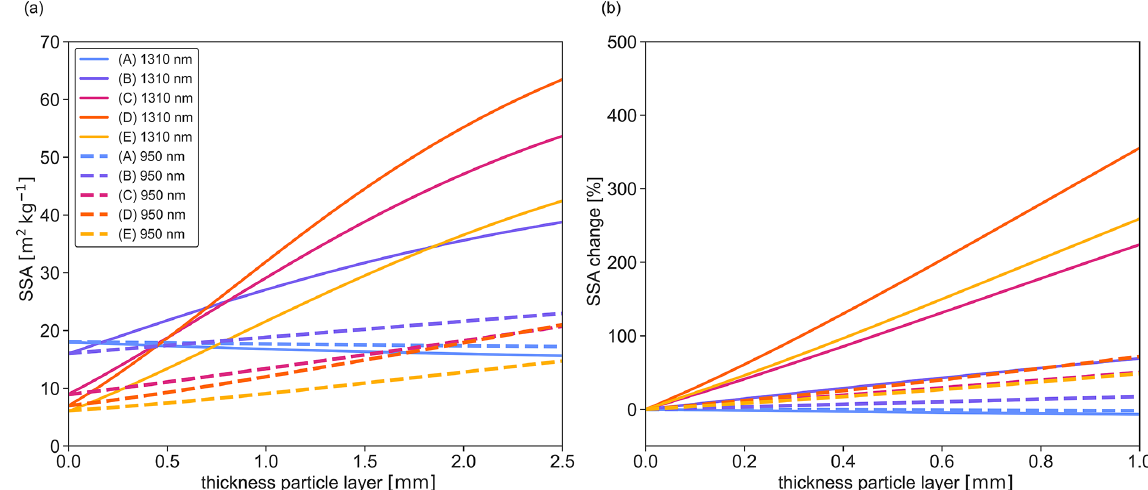
Figure 9. Simulation of a 1m thick snow substrate with a thin ( < 2.5mm) particle layer on top with a density of 200kgm − 3 . Both layers have different SSA values (Table 1). In panel (a) , the TARTES simulations show the SSA at wavelengths of 1310 and 950nm. Panel (b) presents the percentage change in the SSA for wavelengths of 1310 and